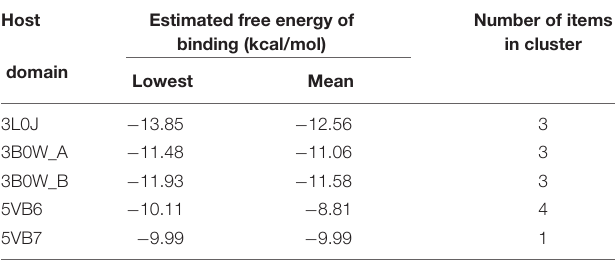
TABLE 3 | The lowest and mean free energy of binding are presented for each considered host